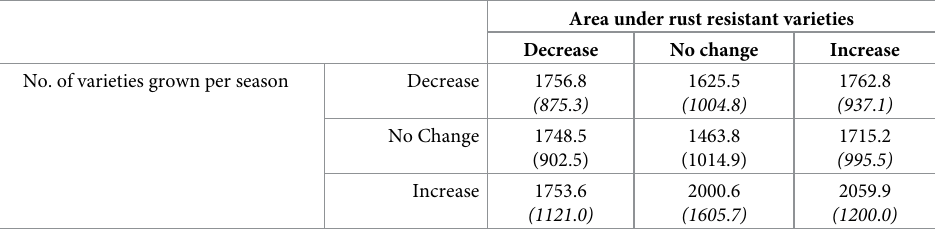
Table 6. Average wheat productivity (kg/ha, self-reported) for different wheat rust coping mechanisms, Ethiopia (2013/14 survey).